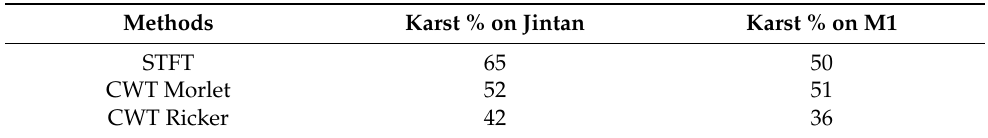
Table 2. Quantitative interpretation by using manual gridding calculation of the karst features delineates by short-time Fourier transform (STFT), continuous wavelet transform (CWT) Morlet, and CWT Ricker spectral decomposition